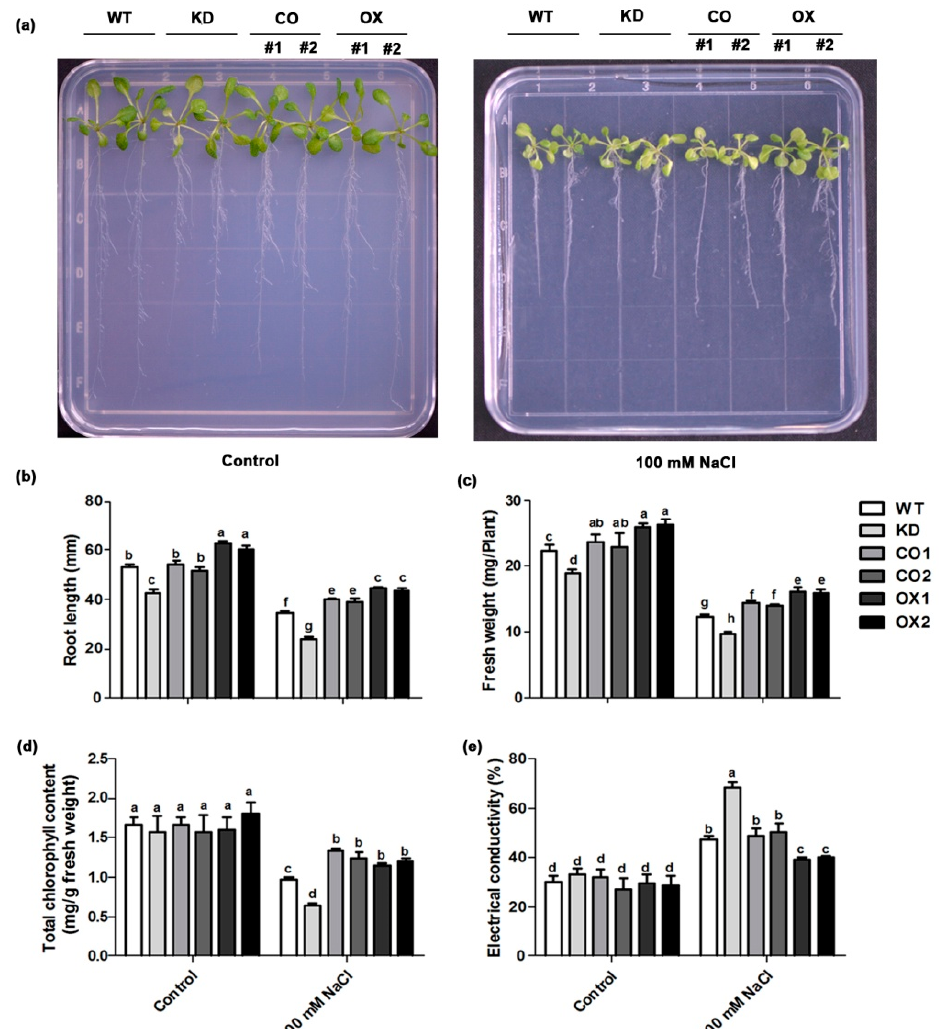
Figure 3. E ff ect of salt stress on seedling growth phenotype, root length, fresh weight, chlorophyll and electrical conductivity in wild type (WT), BvM14-SAMDC -overexpressed in wild type Arabidopsis (OX), atsamdc1 mutant (KD) and transgenic BvM14-SAMDC in the mutant seedlings (CO) leaves. ( a ) 8-day-old WT and transgenic seedlings, grown on MS medium, were transferred to new MS solid agar plates supplemented with 0 or 100 mM NaCl, followed by growth for 10 days; ( b ) root length; ( c ) fresh weight; ( d ) chlorophyll level; and ( e ) electrical conductivity in control and 100 mM NaCl treated seedlings. Di ff erent letters indicate significantly di ff erent at P < 0.05. Three biological replicates were performed.